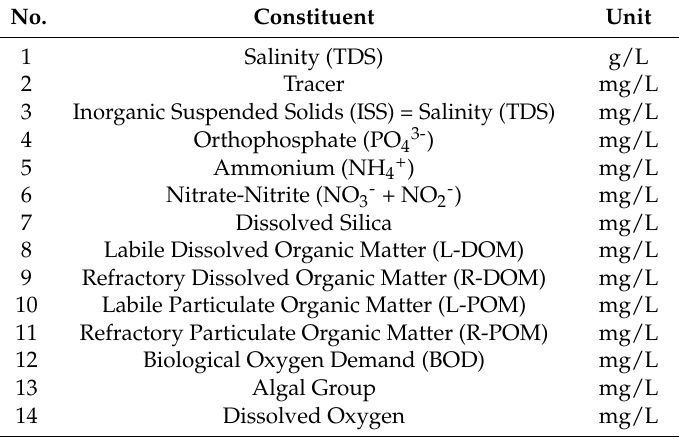
Table 1. Neuse Estuary Eutrophication Model (NEEM) water quality constituents.